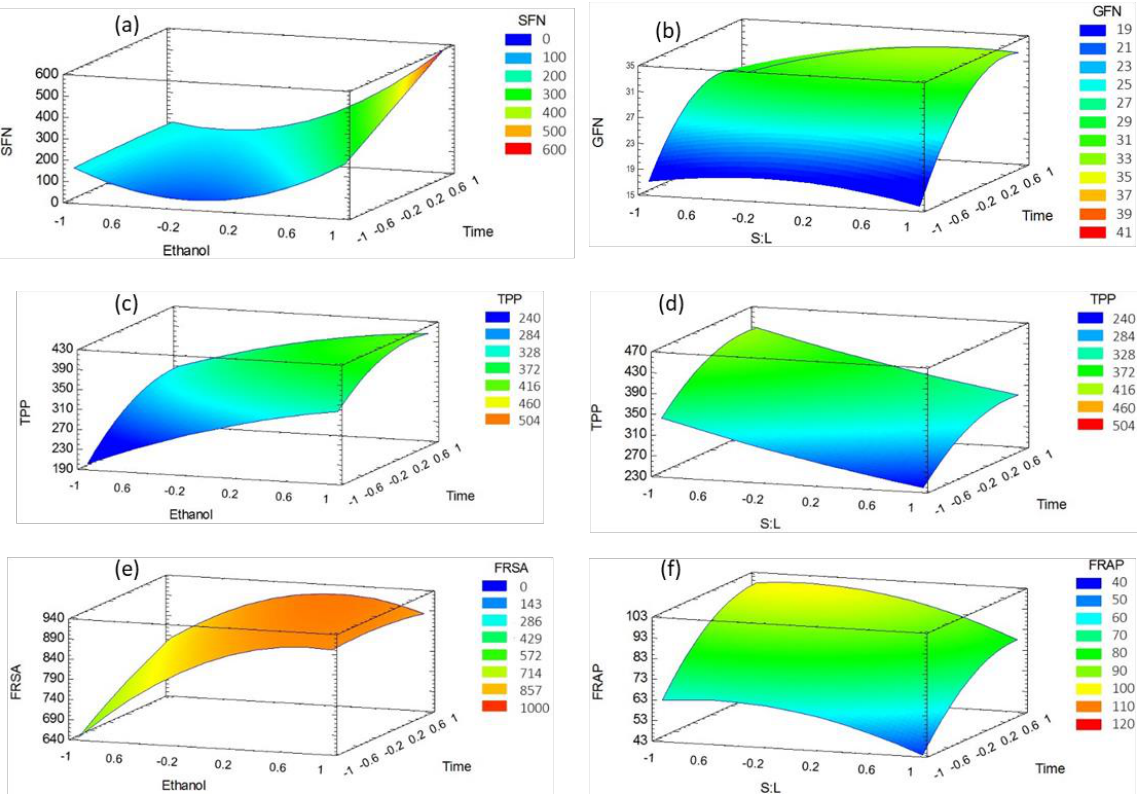
Figure 2. Response surfaces obtained for ( a ) sulforaphane, ( b ) glucoraphanin, ( c , d ) total polyphenols content, ( e ) free radical scavenging ability, and ( f ) ferric-ion-reducing ability.